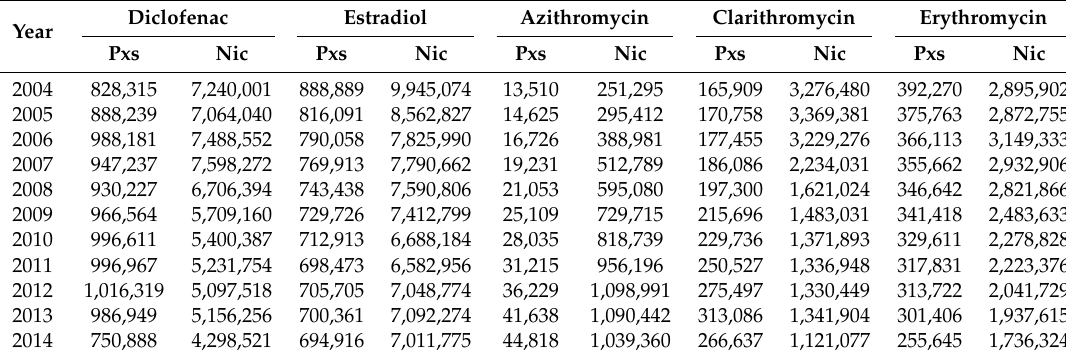
Table B3. Total Prescriptions Items and Total Cost per each Examined Substance from 2004 to 2014 in Scotland.